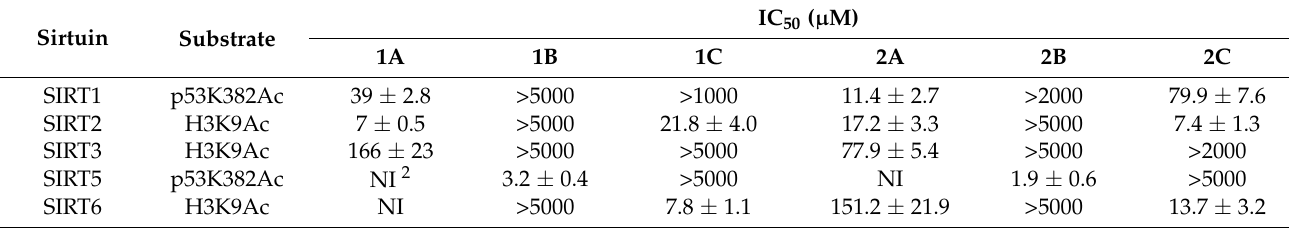
Table 1. IC 50 values of activity-based chemical probes (ABPs). 1